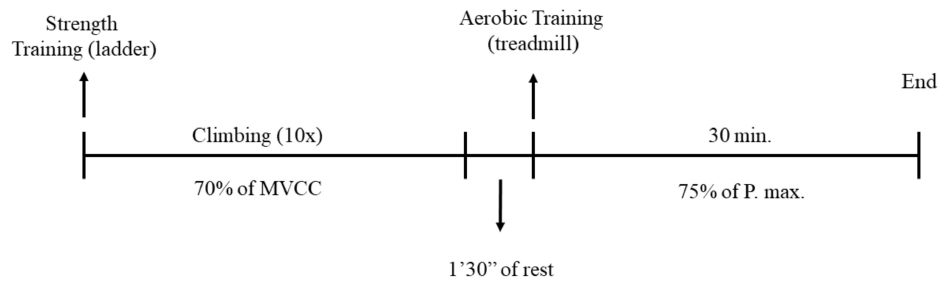
Figure 4. Exercise protocol. The exercise session started with a strength exercise protocol, which consisted of 10 climbs at 70% of the maximum voluntary carrying capacity (MVCC), followed by 30 min running on the treadmill at 75% of the maximum power